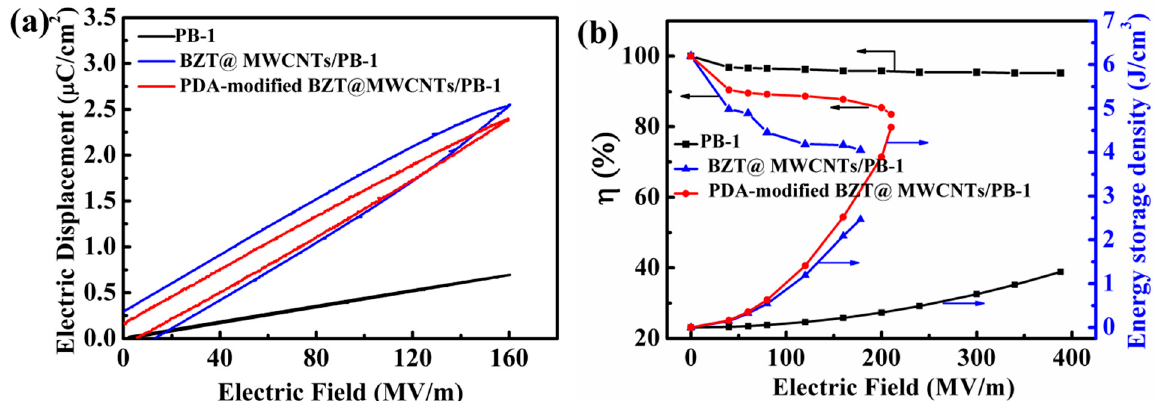
Figure 10. ( a ) Electric displacement electric field loops of the PDA-modified BZT@MWCNTs/PB-1 composite films under an applied field of 160 MV·m − 1 . ( b ) Energy storage density and energy storage efficiency at 1 kHz of the PDA-modified BZT@MWCNTs/PB-1 composite films.